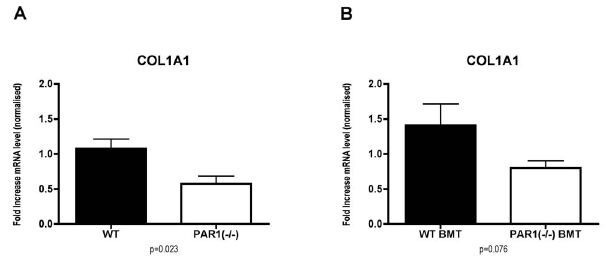
Figure 3. Hepatic collagen I mRNA expression in vivo . A considerable reduction in COL1A1 gene expression was found in PAR1( 2 / 2 ) mice subjected to carbon tetrachloride (CCl 4 ) liver injury compared to WT controls (A). A corresponding reduction in COL1A1 gene expression of lower magnitude was seen WT mice transplanted with PAR1( 2 / 2 ) bone marrow (PAR1( 2 / 2 ) BMT) compared to WT controls transplanted with WT bone marrow (WT BMT) (B). (graphs show mean + SEM, normalised to hypoxanthine guanine